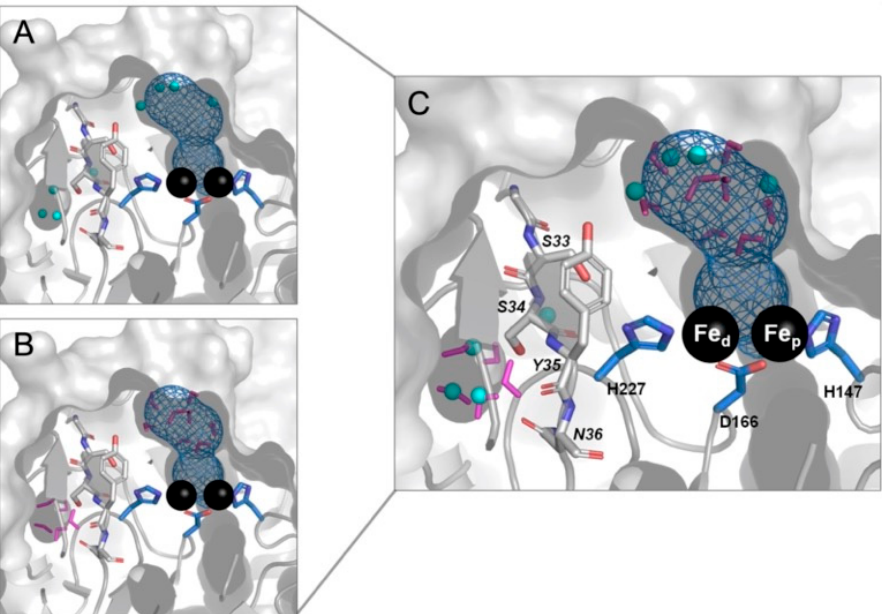
Figure 6. Water molecules observed in the crystallographic and predicted structures. The water molecules present in the crystal structure of the wt enzyme (PDB code: 4D02), within a 5 Å radius from residues 34, 35 and 36, are highlighted as cyan spheres. The small channel is represented as blue mesh, determined using MOLE [28]. The figure was built with PyMOL and the protein’s secondary structure elements are shown using a gray cartoon representation; the molecular surface is also represented in gray. For simplicity, only some residues coordinating the metal center, His227, Asp166 and His147, are displayed, using sticks with the carbons colored in blue and the iron atoms as black spheres, labeled as proximal Fe (Fe p ) and distal Fe (Fe d ). Residues 33, 34, 35 and 36 are highlighted using sticks and labels. The water molecules predicted by Dowser++ [32] are depicted as pink sticks (panel B ). Panel C shows a structural superposition of the water molecules that were observed in the crystal structure (panel A , cyan spheres) with those predicted (panel B , pink sticks).